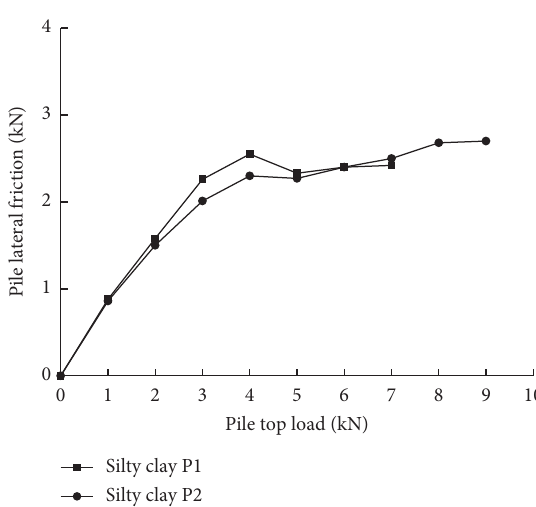
Figure 8: The tip resistance of pile in different soil samples along with load change.